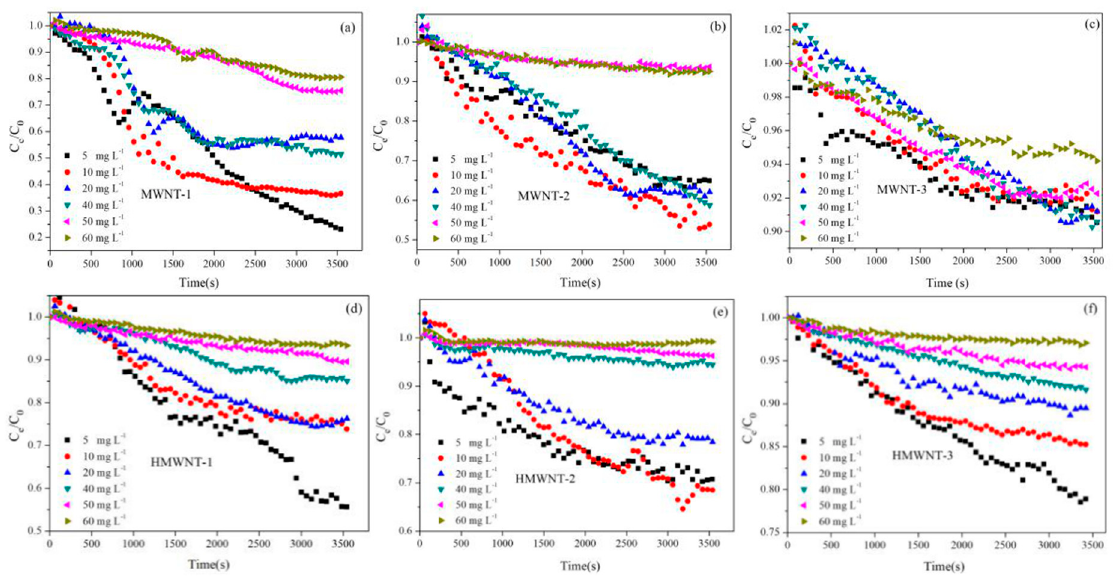
Figure 8. Effect of HA adsorption on sedimentation behaviors of MWNTs ( a – c ) and HMWNTs ( d – f